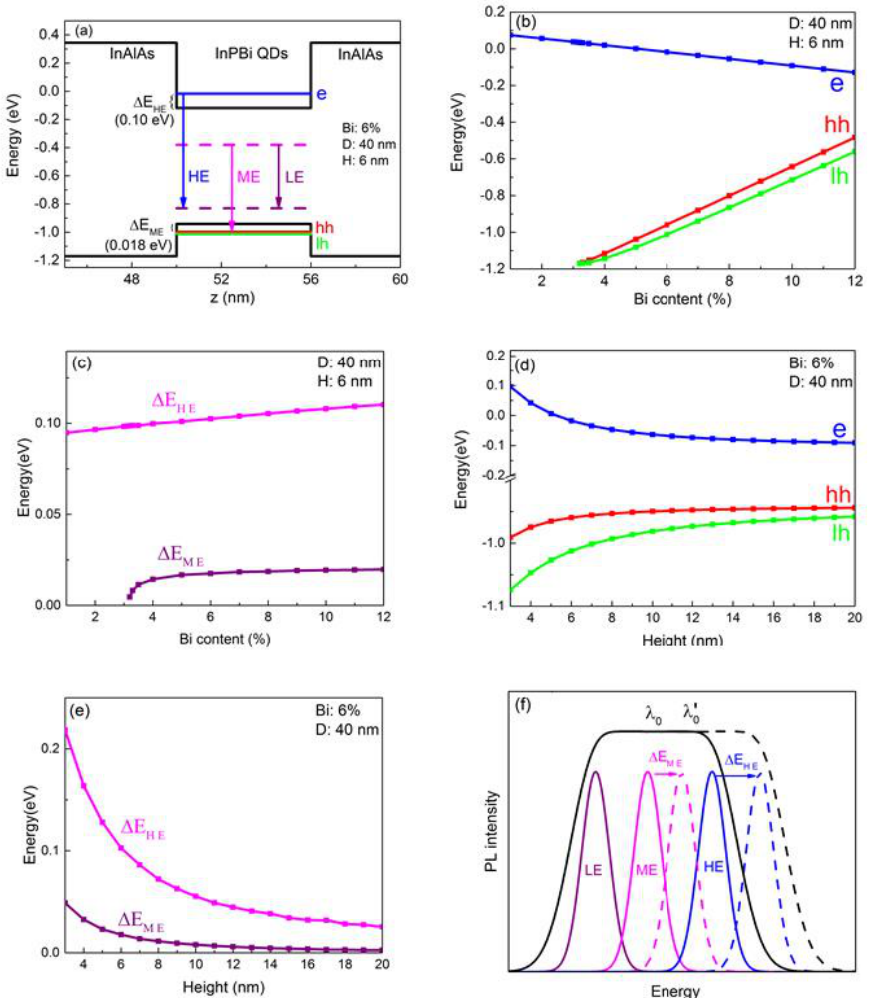
Figure 3. ( a ) the band alignment and carrier recombination processes of an InAlAs/InPBi QD structure plotted along the z axis across the center of the InPBi QD with the Bi content, the diameter and the height of 6%, 40 nm and 6 nm, respectively. The zero in Energy is set as the bottom of the conduction band of InP. The blue, red and green line are the ground state of the electrons, heavy holes and light holes, respectively. ∆ E HE and ∆ E ME are the energy difference between the electron ground state and the conduction band edge of InP 0.94 Bi 0.06 and between the valence band edge and the heavy hole ground state, respectively; ( b , c ) show the dependence of the ground state energy of the electrons (blue), the heavy holes (red) and the light holes (green) ( b ) and the energy difference ∆ E HE (magenta) and ∆ E ME (purple) ( c ) on the Bi content of the InPBi QD with fixed diameter and height of 40 nm and 6 nm, respectively; ( d , e ) show the dependence of the ground state energy of the electrons (blue), the heavy holes (red) and the light holes (green) ( d ) and the energy difference ∆ E HE (magenta) and ∆ E ME (purple) ( e ) on the height of the InPBi QDs with fixed diameter and Bi content of 40 nm and 6%, respectively. The markers indicate the simulated data points; ( f ) diagrammatic sketch of the PL spectrum broadening with the energy increase of the ME and HE transitions. The solid lines represent the LE (purple), ME (magenta), HE (blue) and PL (black) of the InPBi thin films. The dash lines are the ME transition, ME transition and PL (black) of the InAlAs/InPBi QD structure.